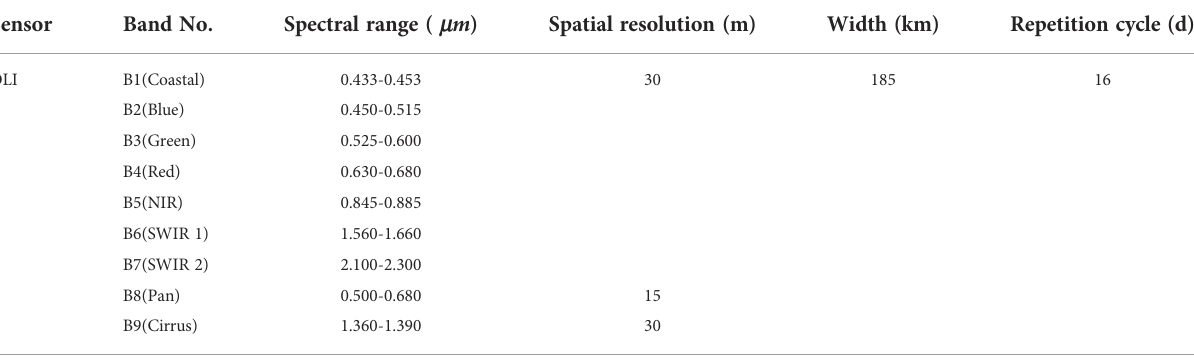
TABLE 2 Information of Landsat-8 OLI.